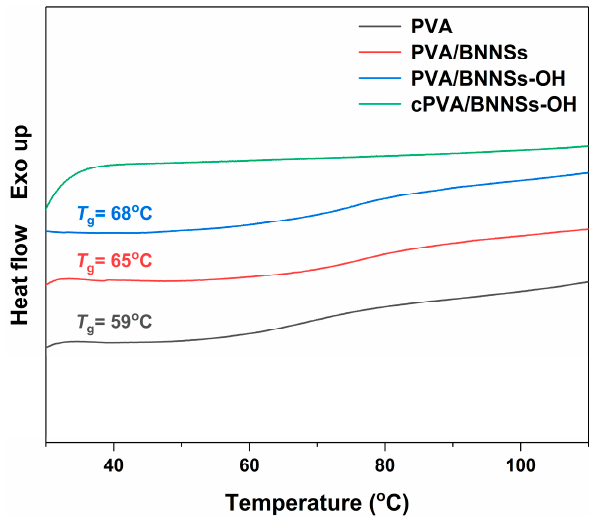
Figure 9. DSC analyses of PVA, PVA/BNNSs, PVA/BNNSs-OH, and cPVA/BNNSs-OH.